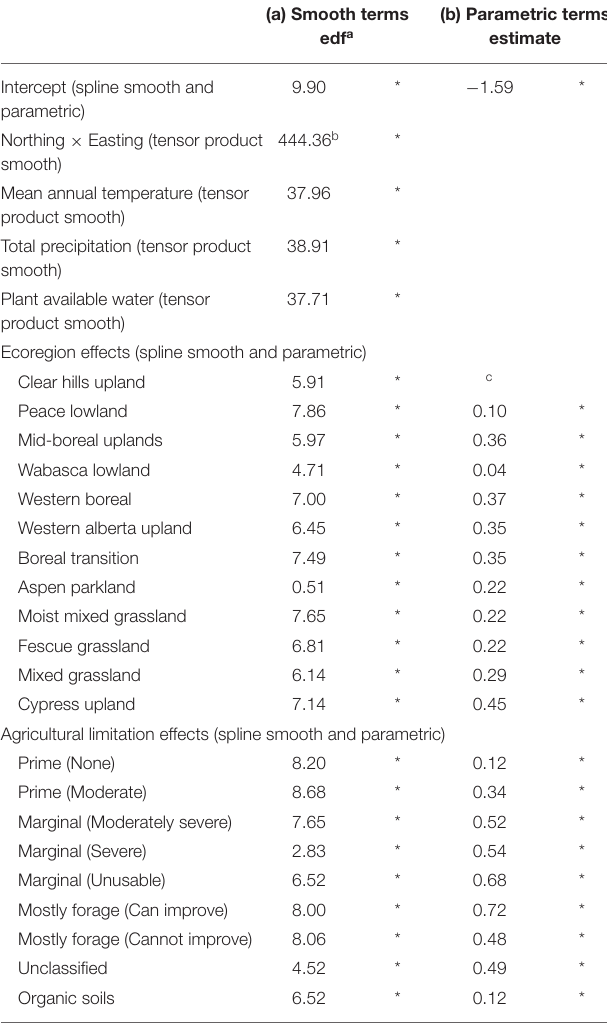
TABLE 2 | Modeling of non-crop land cover